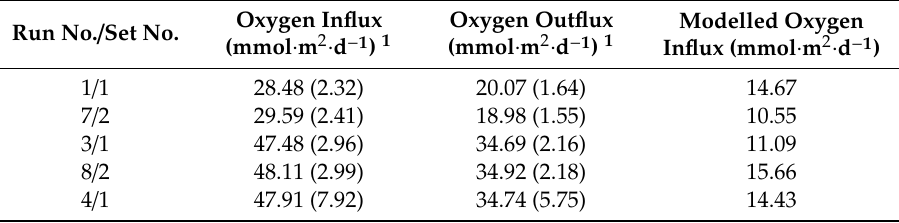
Table 2. Calculated oxygen flux into the sediment (Equation (4)), modelled oxygen influx based on the equations provided by Ahmerkamp et al. [20], and calculated oxygen flux out of the sediment based on the assumption underlying the delta method (Equation (7)). Run No./Set No.